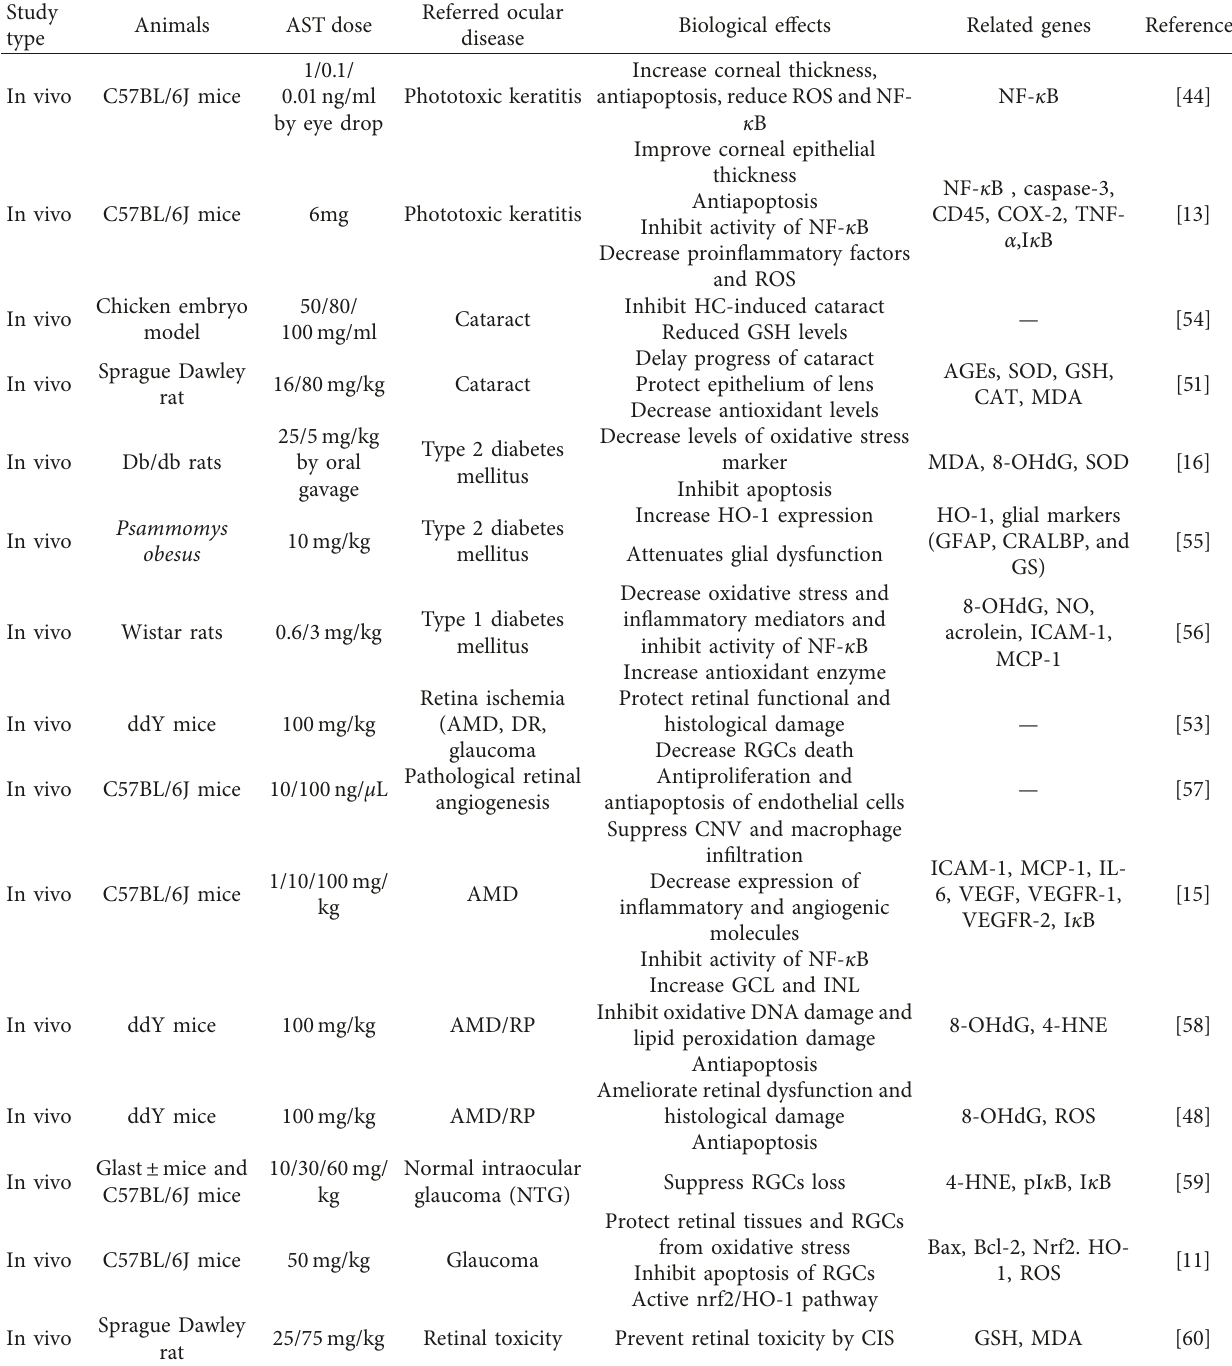
Table 2: Summary of in vivo animal studies on eye and